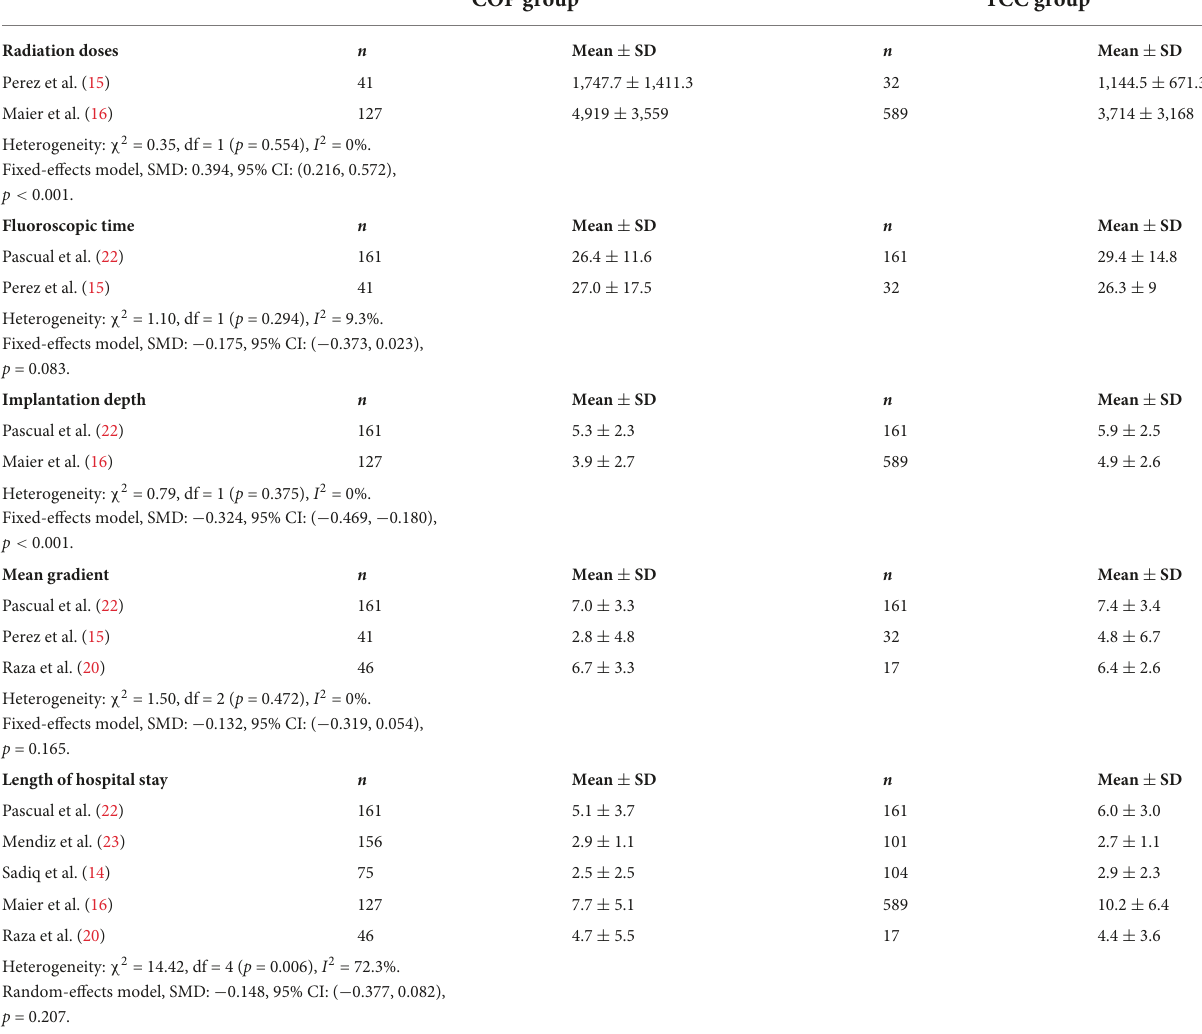
TABLE 2 Secondary outcomes of the meta-analysis (continuous variables). COP group TCC group Radiation doses n Mean ±